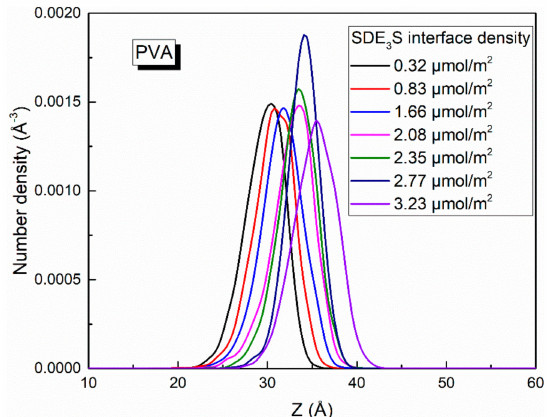
Figure 9. Number density profiles of PVA in SDE 3 S / PVA systems.